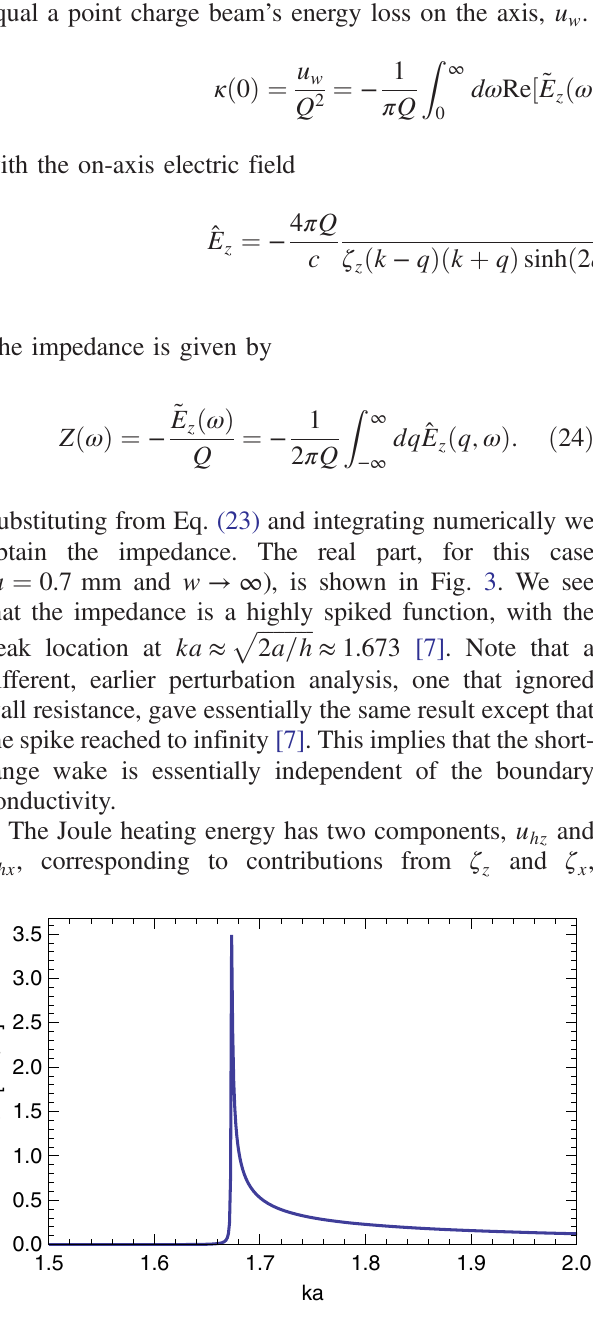
FIG. 4. The real part of the Joule heating impedance Re ð Z Þ þ Re ð Z Þ for the beam on axis in the dechirper with Re ð Z hz hx half aperture a ¼ 0 . 7 mm and plate width w ¼ 12